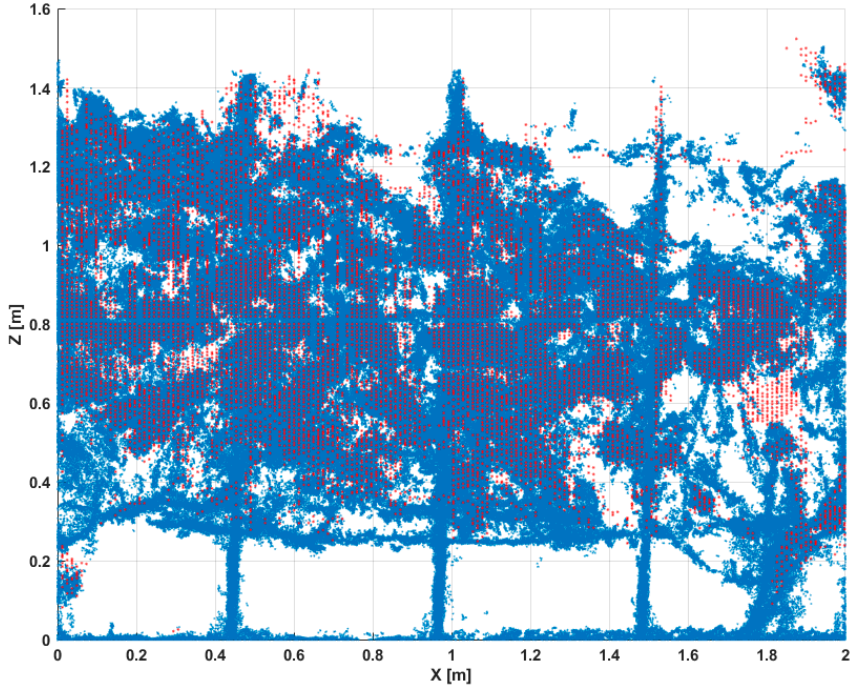
Figure 9. Comparison of point clouds from terrestrial lidar (red) and UAS photogrammetry (blue) in a side view (left side of the canopy).